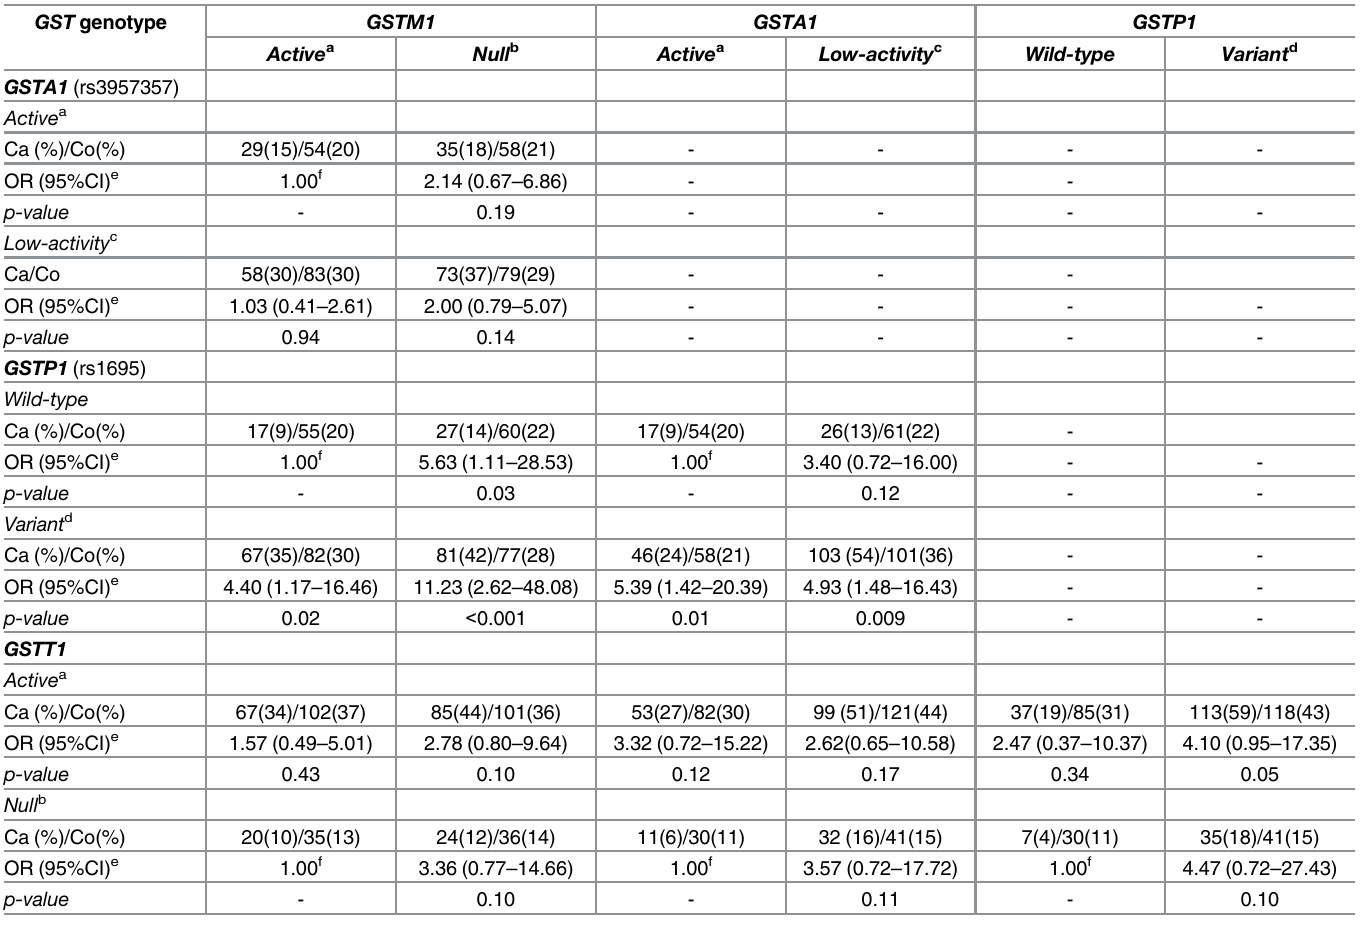
Table 4. Combined effect of GST genotypes on risk of